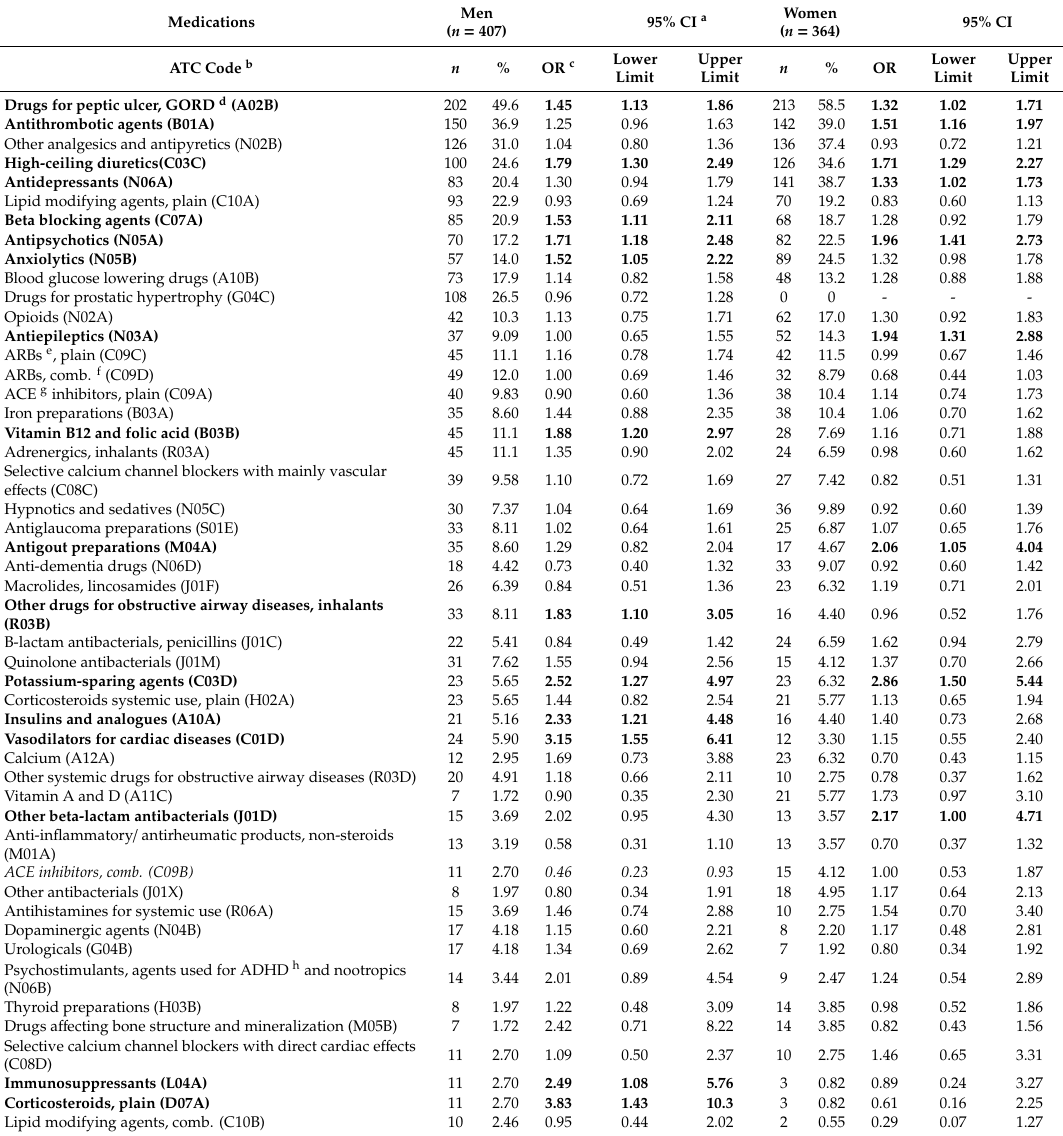
Table 3. Prevalence of medications dispensed during the month prior to cohort entry of individuals that died during the follow-up period, and association with all-cause mortality, by sex.